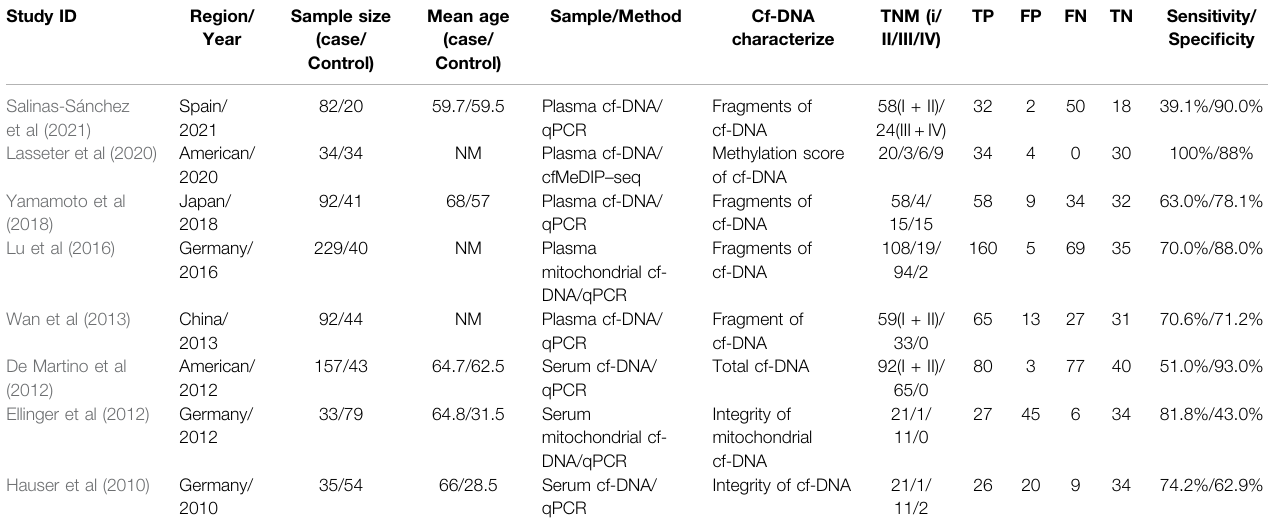
TABLE 1 | Characteristics of Studies Evaluating the cf-DNA Levels of Patients with Renal Cancer